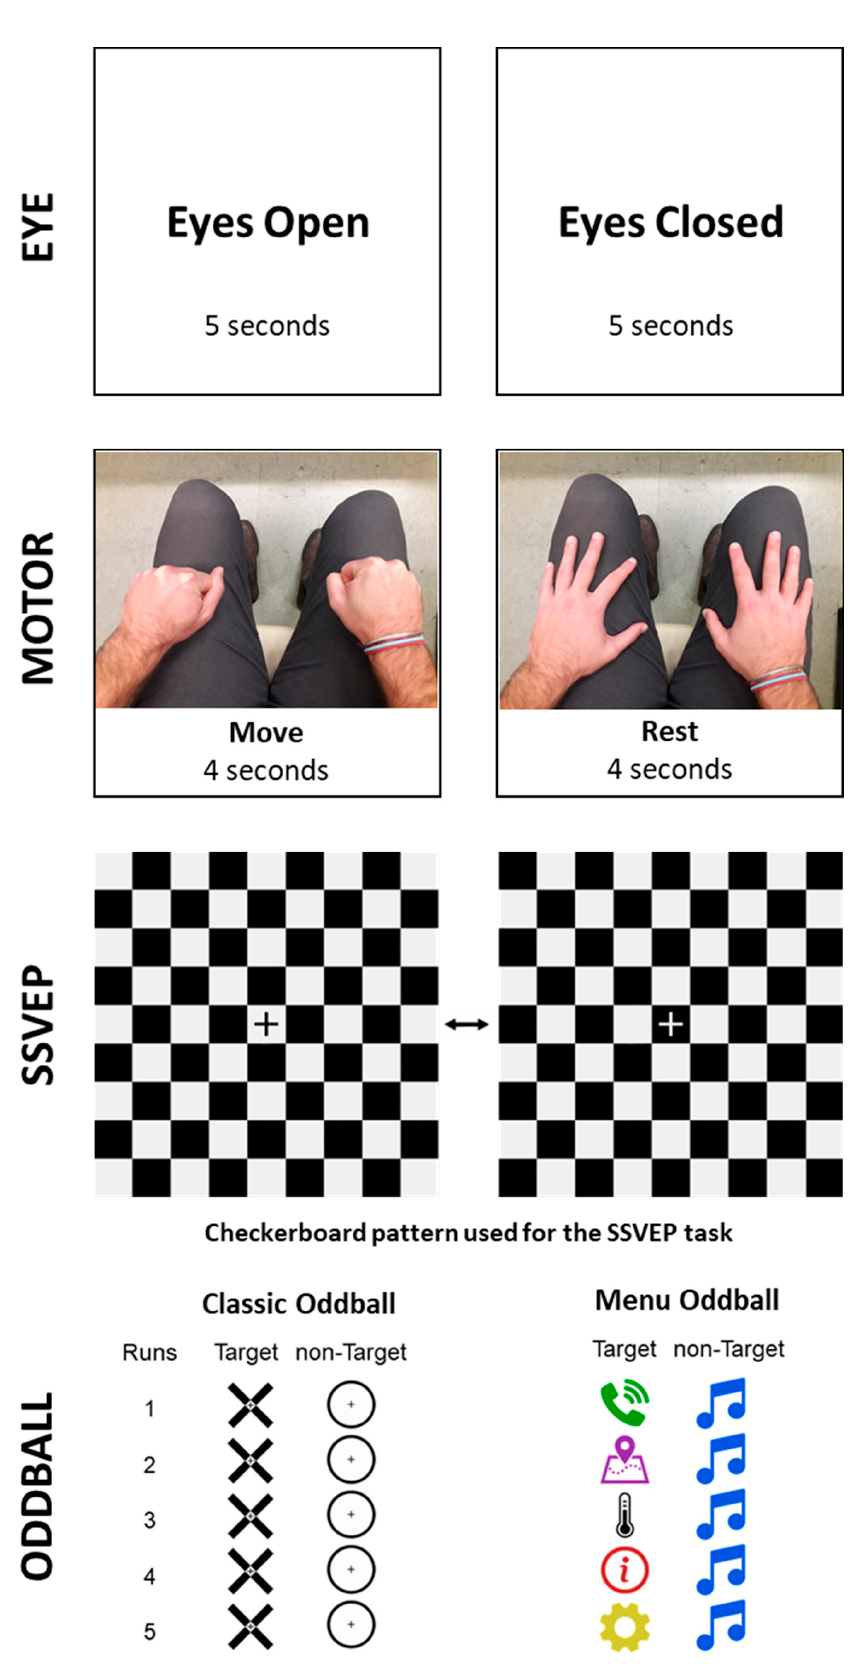
Figure 3. Schematic representation of the Eye and Motor tasks. Stimuli used in the SSVEP and Oddball tasks.